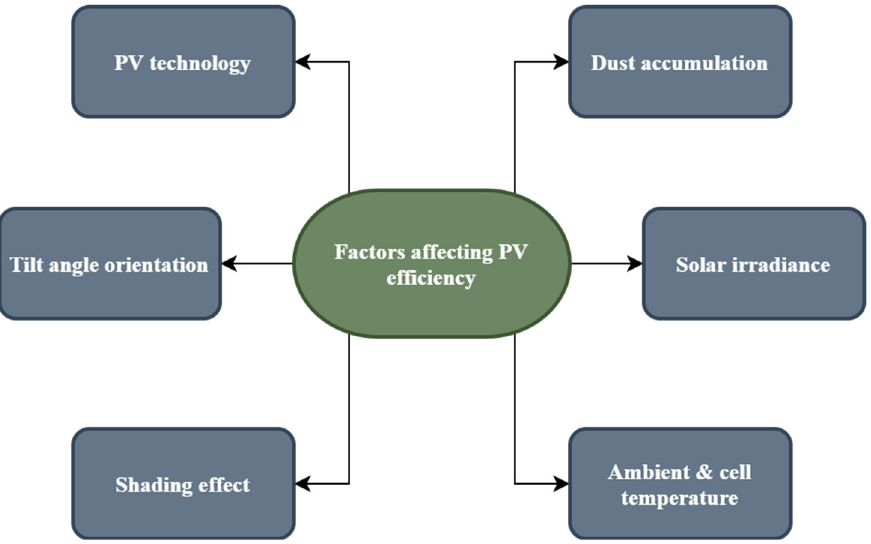
Figure 4. Factors affecting PV system